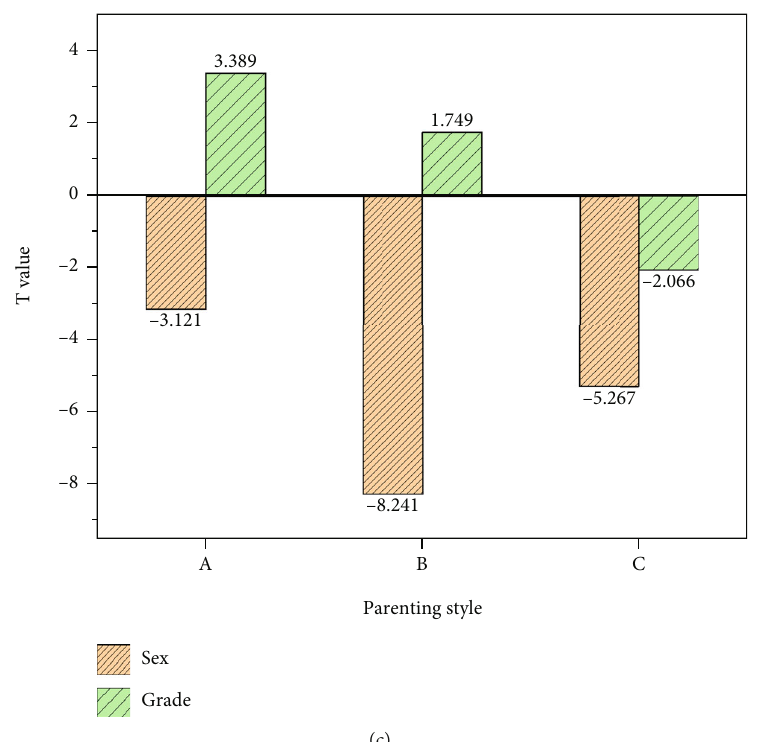
Figure 6: Di ff erence analysis of parenting style in gender and grade. (a) Di ff erence analysis of parenting style in gender; (b) di ff erence analysis of parenting style in grade; (c) t -test of parenting style on gender and